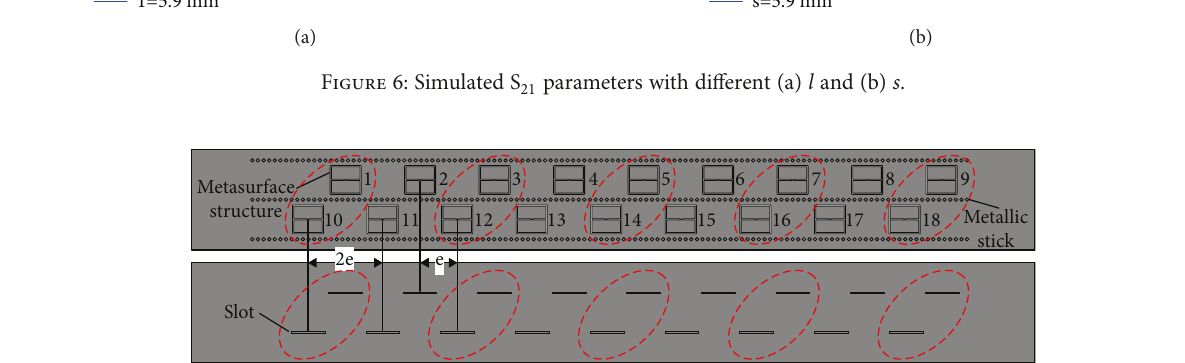
Figure 7: Element arrangement of the proposed waveguide slot array